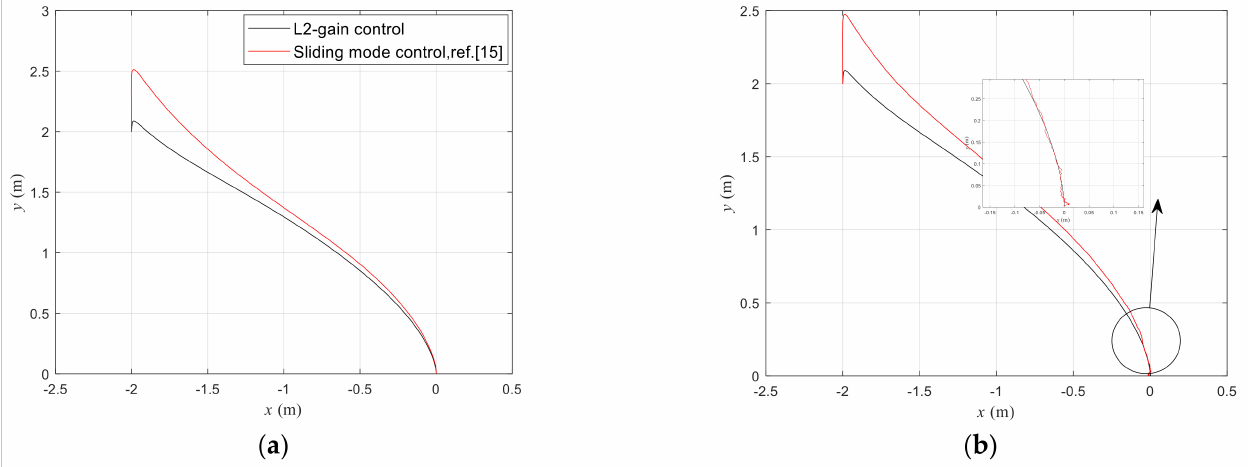
Figure 7. Trajectory of ( x , y ) of the surface ship under control. ( a ) Disturbances at the level of 0.5*randn; ( b ) disturbances at the level of 5*randn.